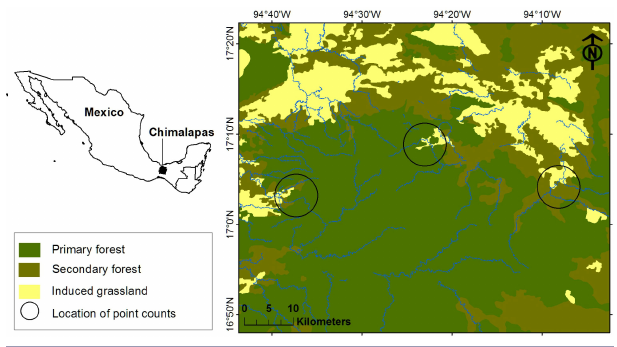
Fig. 1 . The study area in northern Chimalapas, Mexico, showing the modified tropical moist forest landscape, main rivers (dark lines), and the general location of point